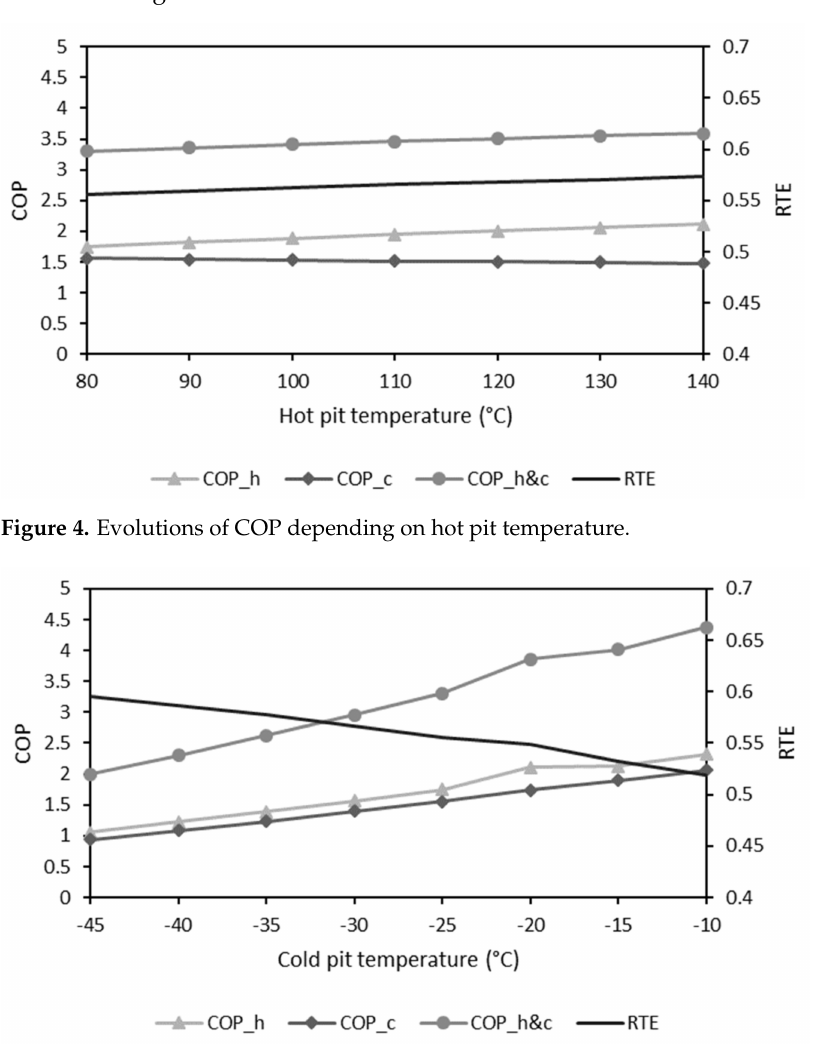
Figure 5. Evolutions of COP depending on cold pit